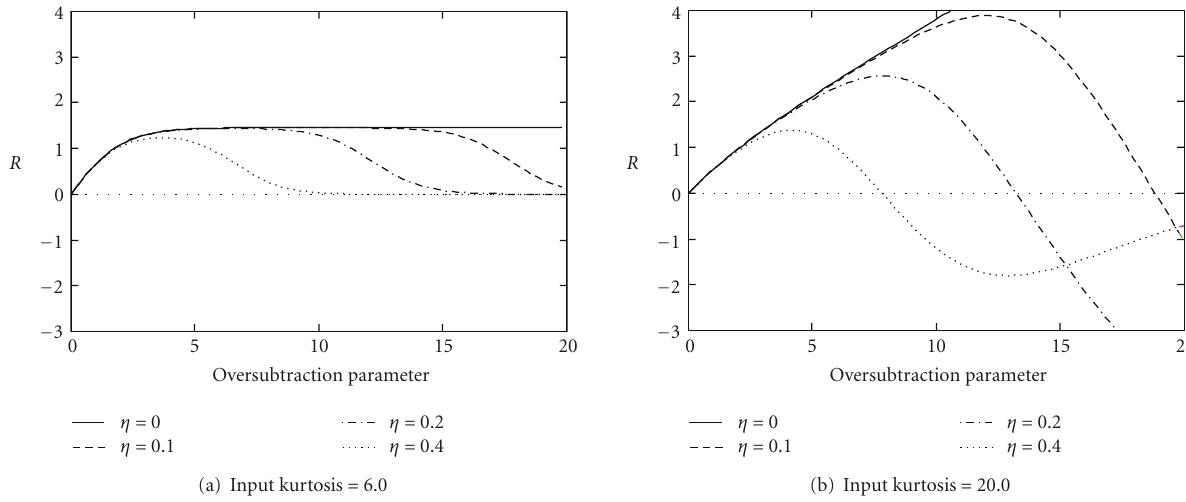
Figure 13: Theoretical kurtosis ratio between BF+SS and chSS+BF for various oversubtraction parameters. In this figure, number of microphones is fixed to 8, and input kurtosis is (a) 6.0 (Gaussian) and (b) 20.0 (super-Gaussian).